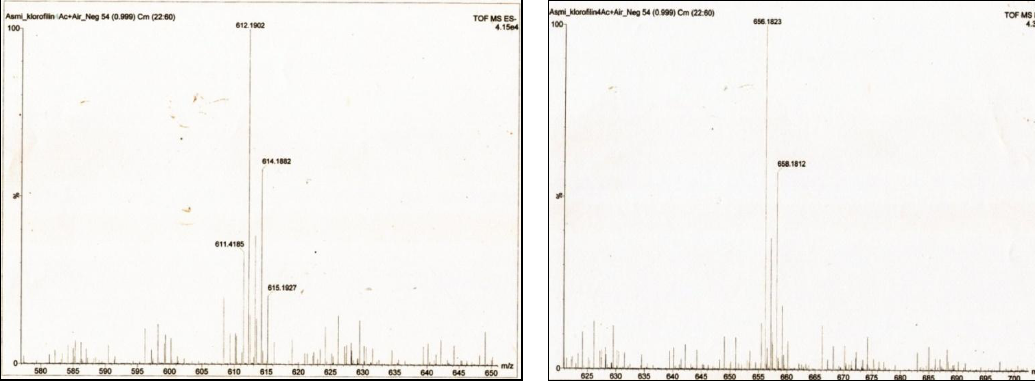
Figure 2. MS spectra of Cu(II)chlorin e 4 (left) and Cu(II)chlorin e 6 (right)